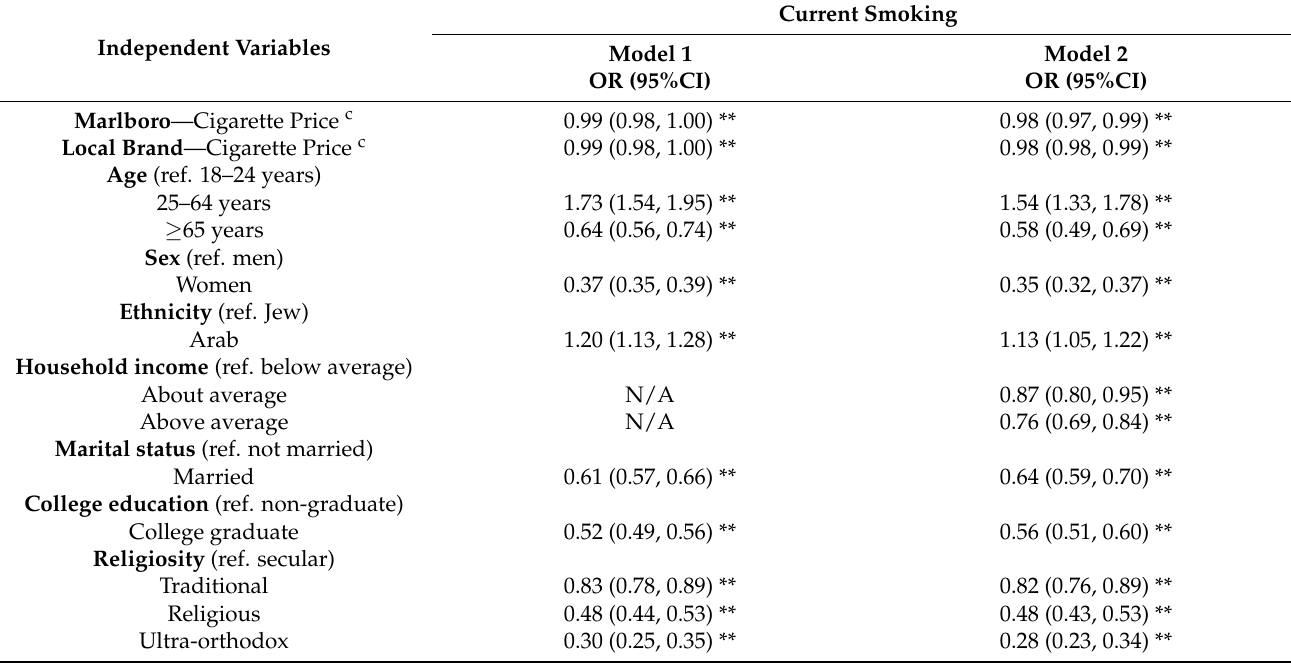
Table 2. Cigarette Prices and Smoking Prevalence among Adults in Israel a : Logistic Regression b